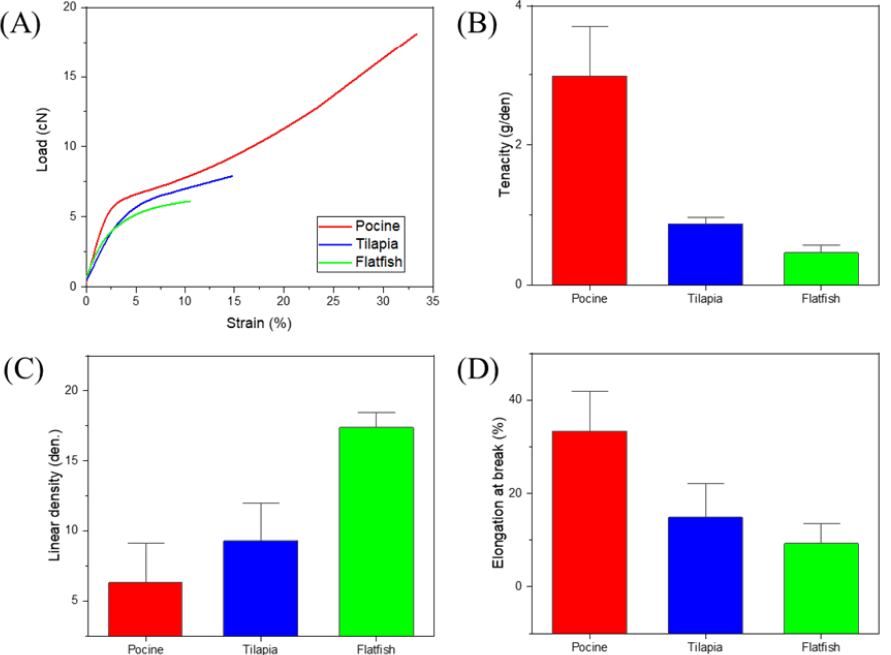
Figure 5. Mechanical properties of porcine, tilapia, and flatfish single composition collagen fibers. ( A ) typical load-strain behavior for each fiber, ( B ) tenacity of each fiber, ( C ) linear density of each fiber, and ( D ) elongation at break of each fiber. At least 20 fibers were analyzed for each case with standard deviation.